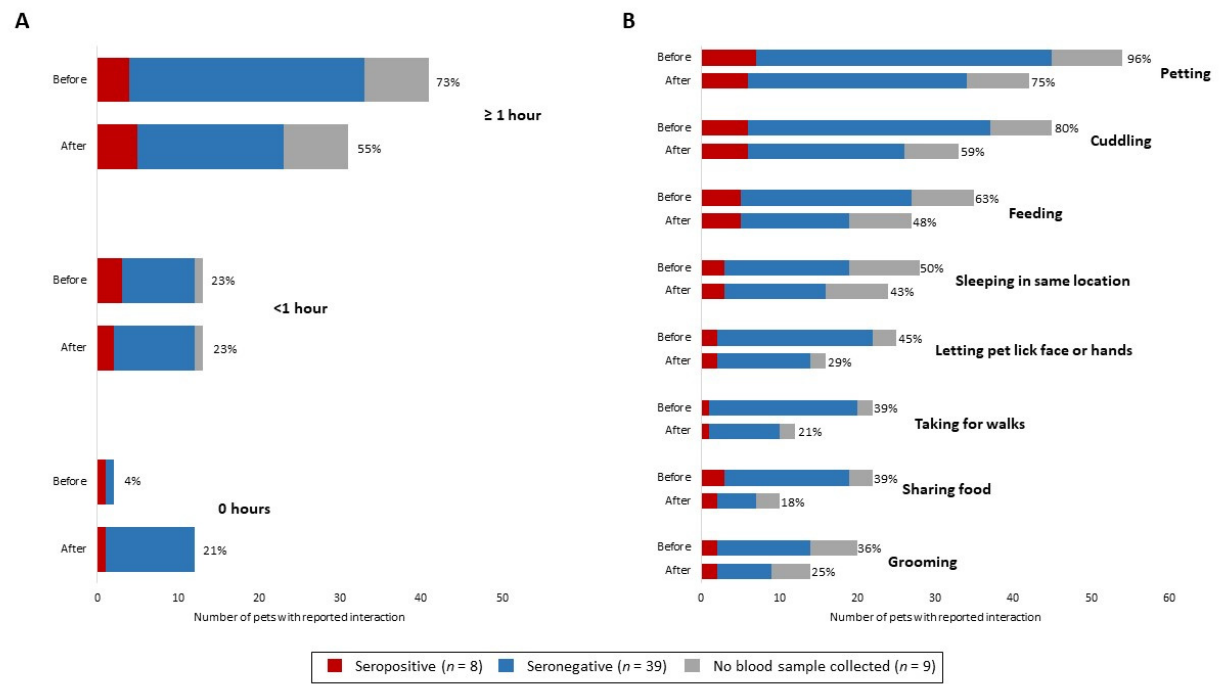
Figure 3. ( A ) Reported duration of interaction per day and ( B ) types of interactions between human index patients and pets in each household before and after human index patient diagnosis, by pet serostatus—One Health COVID-19 Household Transmission Investigation, April–May 2020.